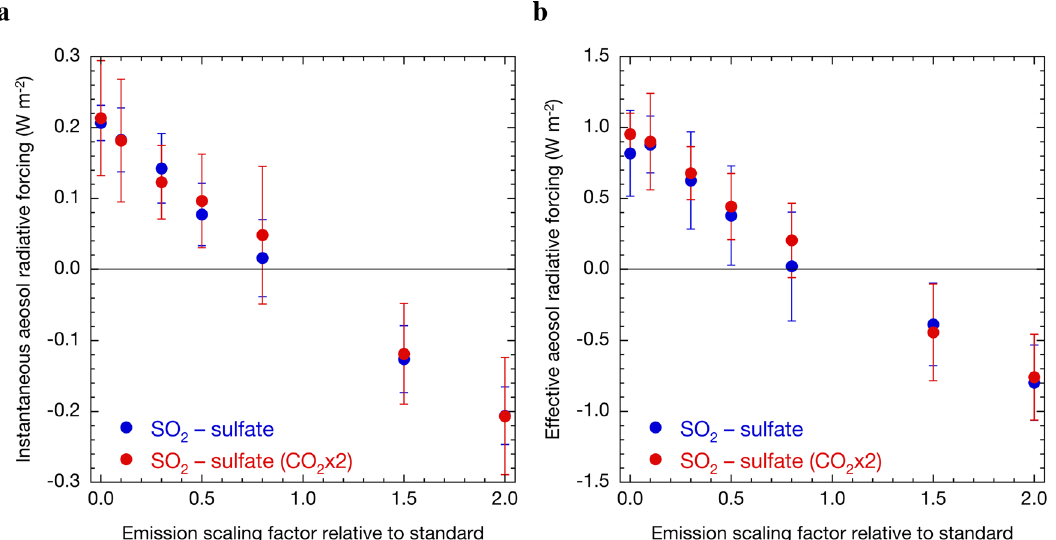
Figure 2. Sensitivity of radiative forcing to changes in SO 2 emissions. Global and annual mean instantaneous aerosol radiative forcing ( a ) and effective radiative forcing ( b ) under present (blue) and doubled (red) CO 2 concentrations with the SO 2 emission perturbations due to fuel sources relative to present emissions simulated by the MIROC–SPRINTARS. Error bars represent the standard deviation of the global and annual means obtained from the analyzed 10-year integrals.